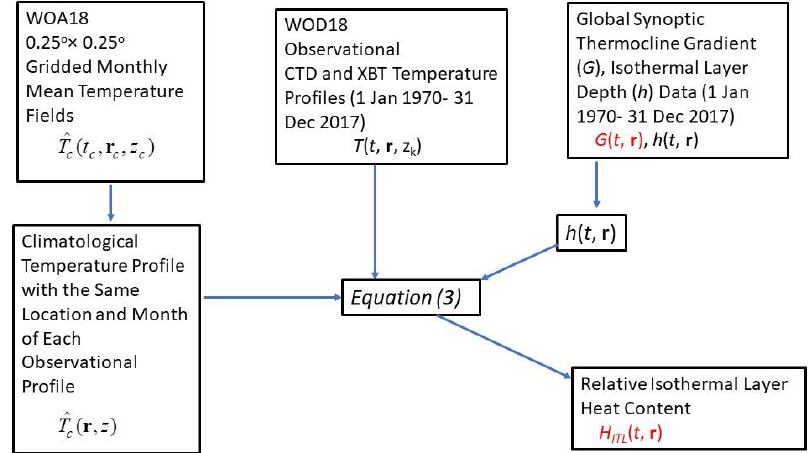
Figure 2. Flow chart for establishing 1,111,647 data pairs of [ H ITL ( t , r ), G ( t , r )] for the global oceans from 1 January 1970 to 31 December 2017.